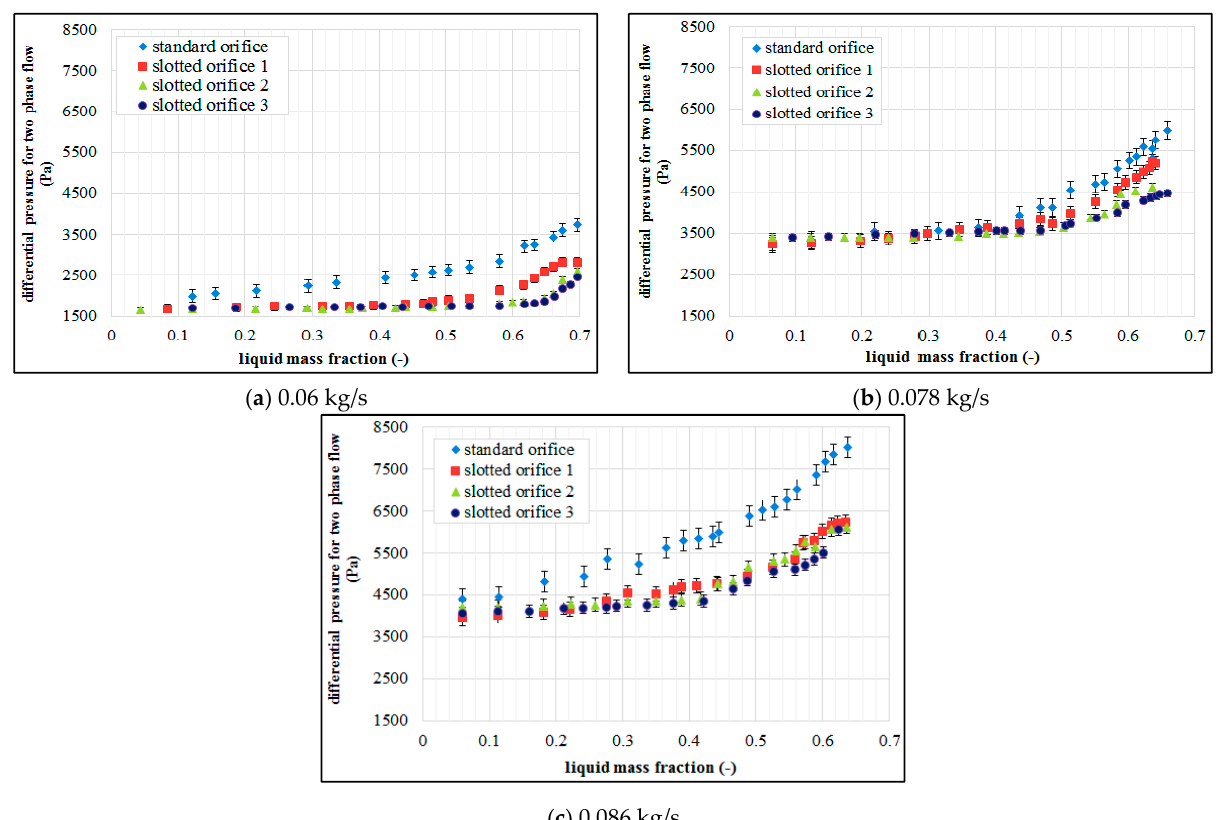
Figure 4. Relations between differential pressures and water mass fraction for air flow rates.